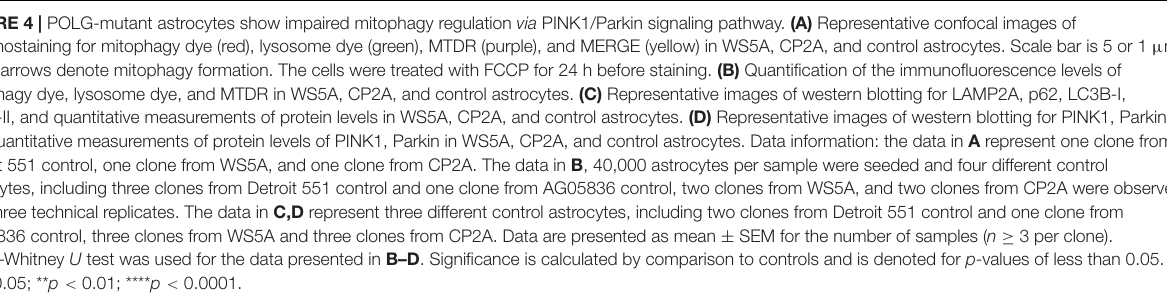
FIGURE 4 | POLG-mutant astrocytes show impaired mitophagy regulation via PINK1/Parkin signaling pathway. (A) Representative confocal images of immunostaining for mitophagy dye (red), lysosome dye (green), MTDR (purple), and MERGE (yellow) in WS5A, CP2A, and control astrocytes. Scale bar is 5 or 1 µ m. White arrows denote mitophagy formation. The cells were treated with FCCP for 24 h before staining. (B) Quantification of the immunofluorescence levels of mitophagy dye, lysosome dye, and MTDR in WS5A, CP2A, and control astrocytes. (C) Representative images of western blotting for LAMP2A, p62, LC3B-I, LC3B-II, and quantitative measurements of protein levels in WS5A, CP2A, and control astrocytes. (D) Representative images of western blotting for PINK1, Parkin and quantitative measurements of protein levels of PINK1, Parkin in WS5A, CP2A, and control astrocytes. Data information: the data in A represent one clone from Detroit 551 control, one clone from WS5A, and one clone from CP2A. The data in B , 40,000 astrocytes per sample were seeded and four different control astrocytes, including three clones from Detroit 551 control and one clone from AG05836 control, two clones from WS5A, and two clones from CP2A were observed with three technical replicates. The data in C,D represent three different control astrocytes, including two clones from Detroit 551 control and one clone from AG05836 control, three clones from WS5A and three clones from CP2A. Data are presented as mean ± SEM for the number of samples ( n ≥ 3 per clone). Mann–Whitney U test was used for the data presented in B–D . Significance is calculated by comparison to controls and is denoted for p -values of less than 0.05. * p < 0.05; ** p < 0.01; **** p <